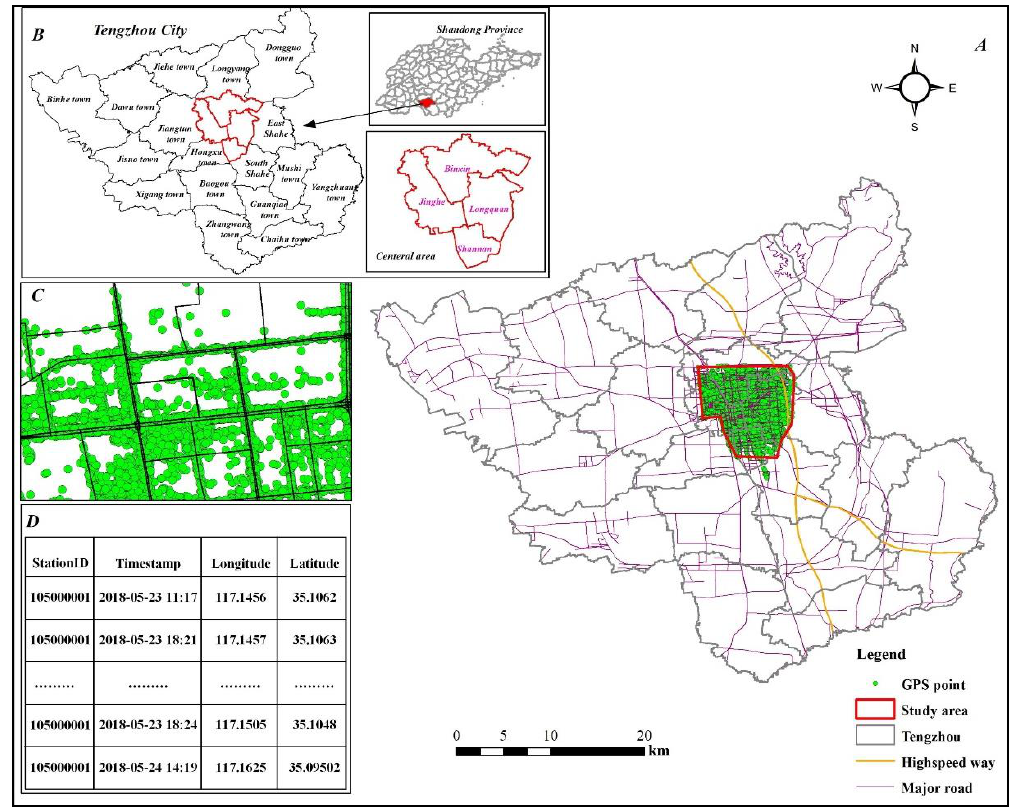
Figure 1. Study area and trajectory data. Part A shows the study area in Tengzhou, and the green dots indicate the trajectory data for the shared e-bikes. Part B shows the location of Tengzhou City in Shandong Province. Part C shows the spatial pattern of the trajectory data in Tengzhou. Part D illustrates the attributes of raw trajectory GPS points.